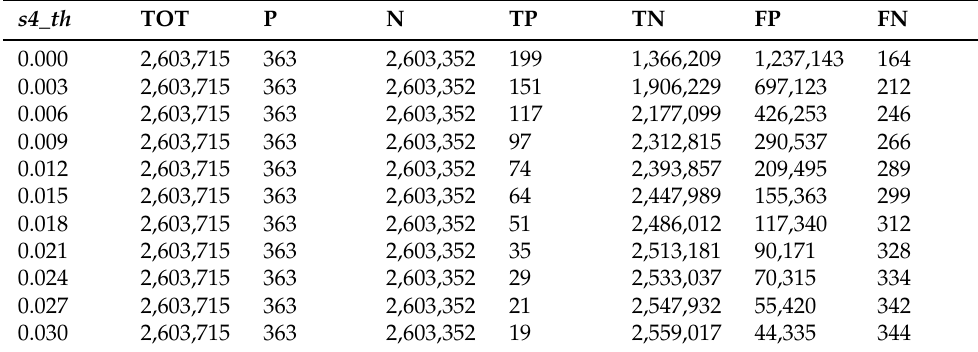
number of pixels with valid data during the period studied. Positives (P) and Negatives (N) refer to the pixels with earthquakes closer than the radius, and TP, TN, FP, and FN are